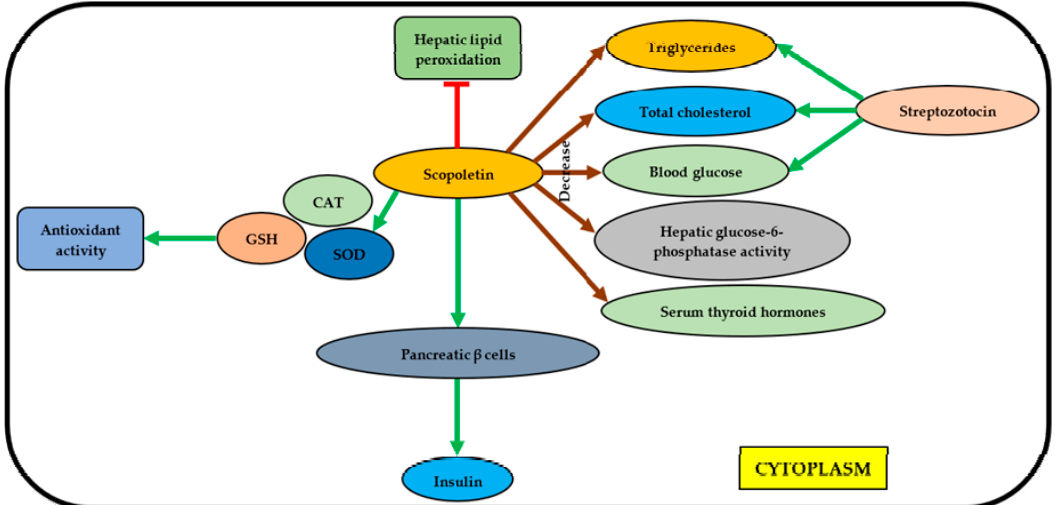
Figure 3. The mechanisms of antidiabetic activity exhibited by scopoletin. GSH, glutathione; CAT, catalase; SOD, superoxide dismutase.